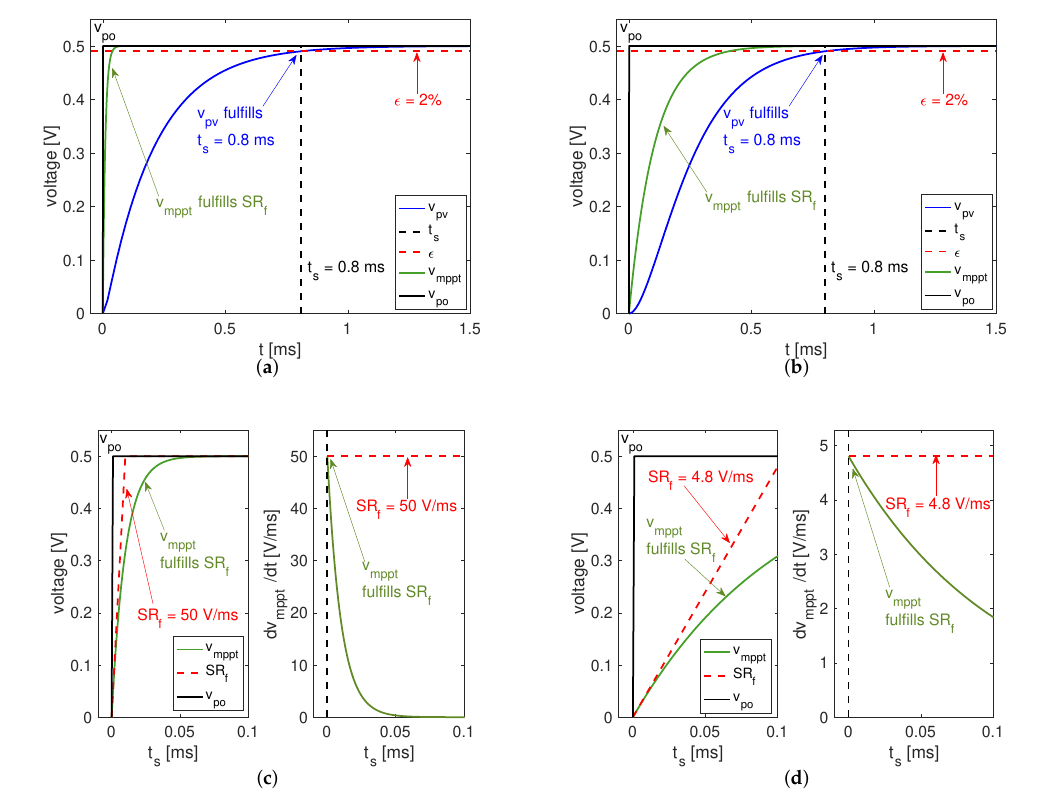
Figure 7. Time response and v mppt derivative of Option 1 (high Ω ) and Option 2 (low Ω ). ( a ) Time response of Option 1 (high Ω ): Ω = 100 krad/s, k 1 = 0.49 A/V, t s = 0.8 ms. ( b ) Time response of Option 2 (low Ω ): Ω = 9.6 krad/s, k 1 = 0.61 A/V, t s = 0.8 ms. ( c ) Option 1 (high Ω ) fulfills the v